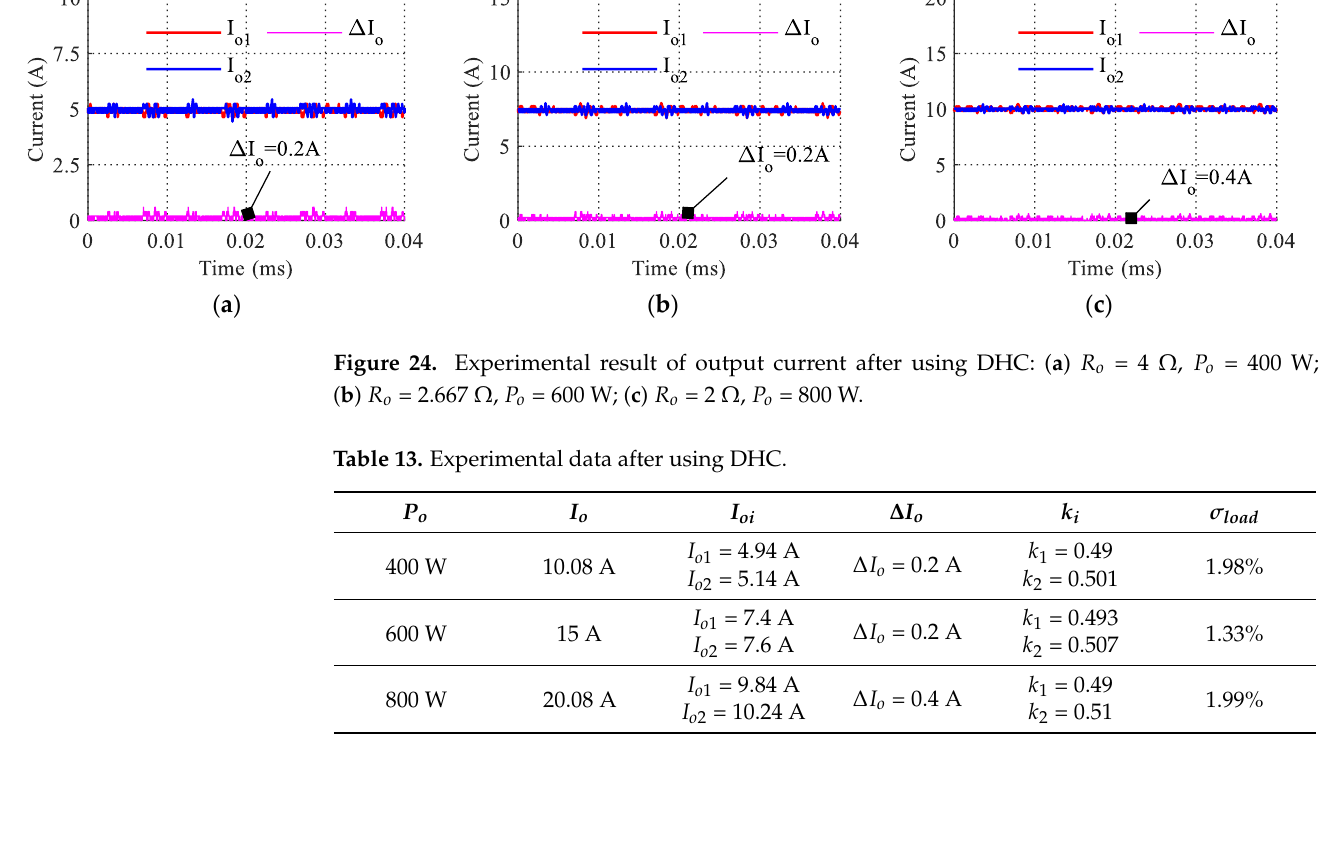
( b ) Figure 25. Experimental output current waveforms under 800 W – 400 W load transient: ( a ) DHC control; ( b ) conventional PI control. 6. Conclusions The IPOP-PSFB converter, that consists of multiple PSFB modules connected in par- allel at the input and output, is a very attractive solution for expanding PSFB converter output power level application. Manufacturing differences make the output current dif- ferent between modules. Therefore, it is to ensure that each module output current is shared evenly.